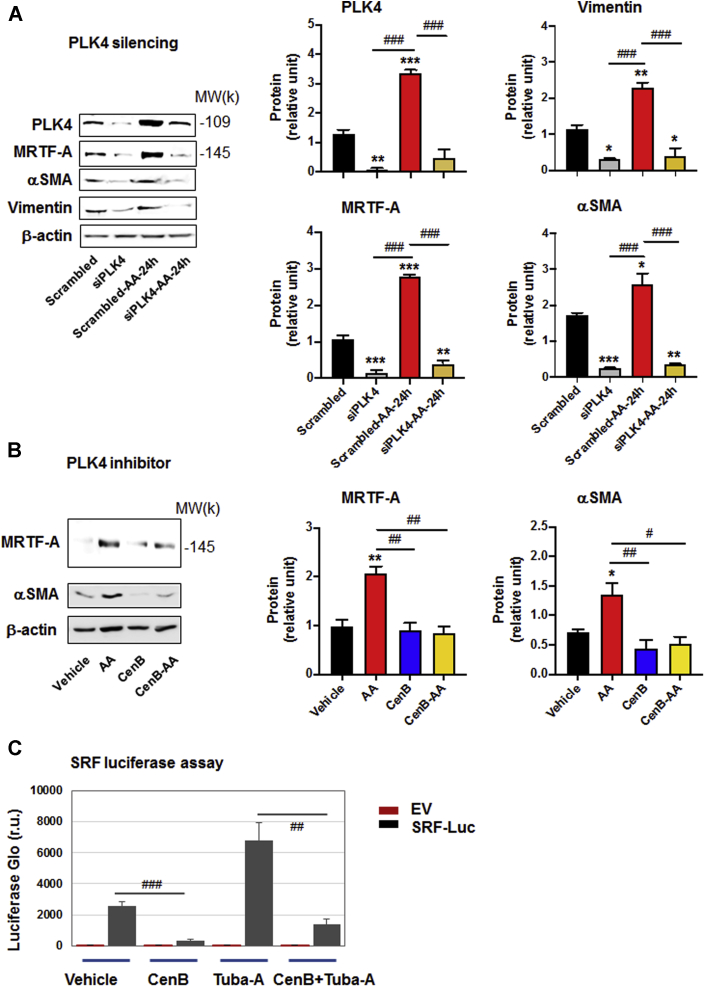
PLK4 Inhibition Reduces MRTF-A Protein and SRF Activity(A) Effect of PLK4 silencing on MRTF-A. Cells were transfected with scrambled or PLK4-specific siRNA for 48 h in the complete medium, starved overnight, and then stimulated with solvent or AA for 24 h before harvest for Western blotting. (B) Effect of PLK4 inhibition on MRTF-A. Cells were pretreated with 1 μmol/l CenB (or vehicle) and then stimulated with solvent or AA for 48 h before harvest for Western blotting. Mean ± SEM, n = 3 experiments, 1-way ANOVA/Bonferroni test: #p < 0.05; ##p < 0.01; ###p < 0.001. ∗p < 0.05. ∗∗p < 0.01; ∗∗∗p < 0.001 compared with the control of scrambled siRNA or vehicle without AA stimulation (the first bar in each plot). (C) Luciferase reporter assay of SRF transcriptional activity. Cells were transfected with the empty vector control or the SRF-luciferase vector, followed by luminescence reading. The condition with 5 μmol/l tubastatin-A, a histone deacetylase 6 inhibitor and a novel SRF stimulator (13), served as a positive control. Mean ± SEM, n ≥3 experiments, Student t-test: ##p < 0.01; ###p < 0.001 (between 2 gray bars). MRTF-A = myocardin-related transcription factor A; SRF = serum response factor; other abbreviations as in Figure 1.